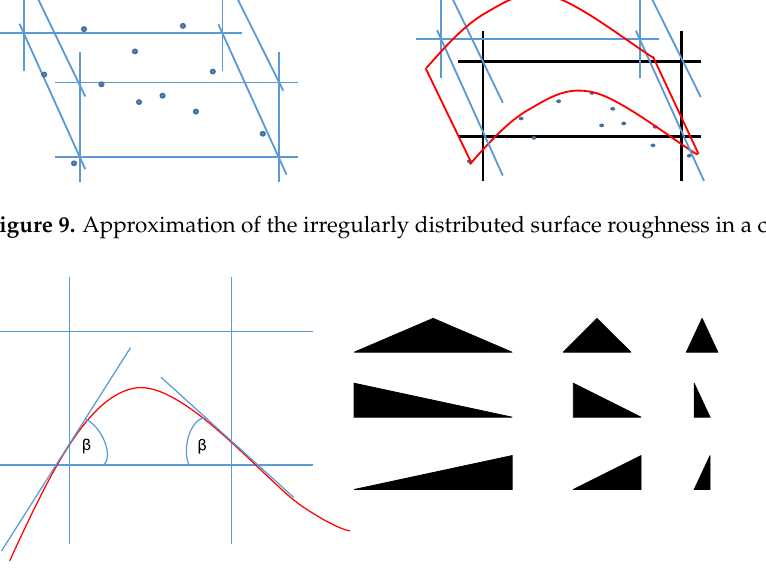
Figure 10. Explanations of the DPM procedure: ( left ) approximation to a regular roughness by considering the β -angles; ( right ) variations of different triangles for 3 selected angles (not to